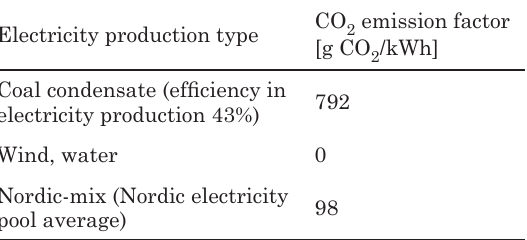
emission factors by electricity table 3. co 2